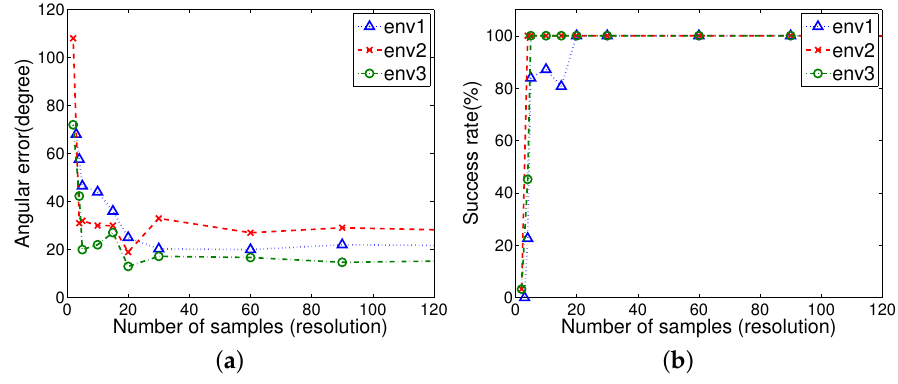
Figure 13. Performance vs. resolution in the H-DELV method ( a ) angular error vs. resolution; ( b ) success rate vs.